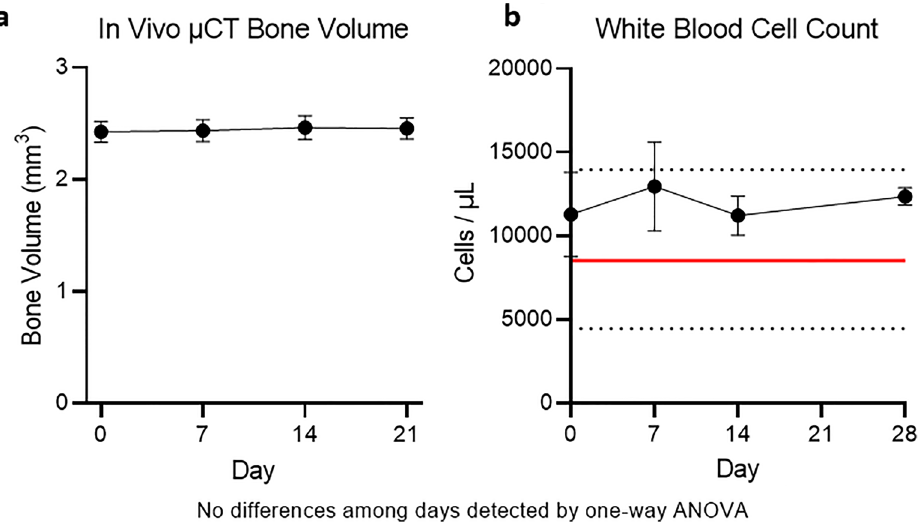
Figure 2. In vivo µCT imaging of five naïve mice shows no imaging-induced effects on ( a ) bone volume, ( b ) or white blood cell count. Horizontal black dotted lines represent a standard reference range of values for C57BL/6 mice from Charles River Laboratories (Wilmington, MA) and horizontal red lines indicate the mean values from C57BL/6 and DBA/1J mice as provided by Jackson Laboratory (Bar Harbor, ME). Standard mean values for DBA/1J mice were provided by the vendor, Jackson Laboratories. No statistical differences among time points were detected by a one-way